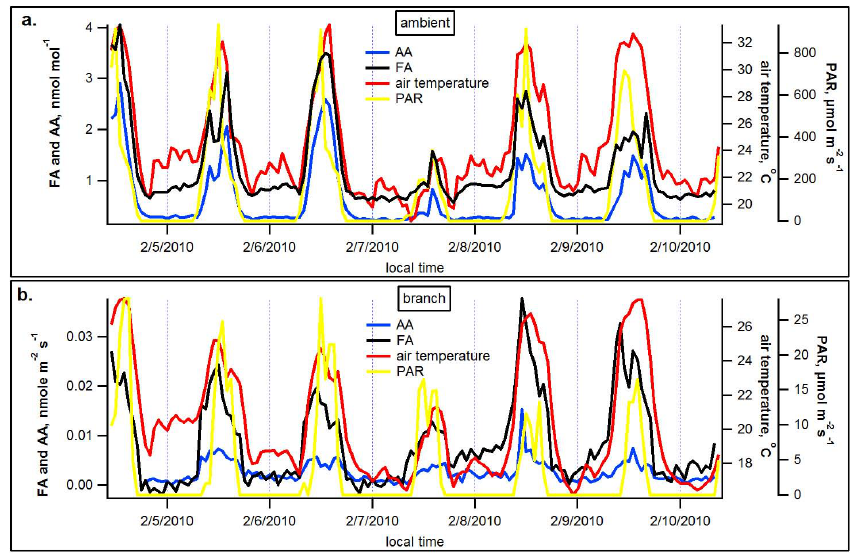
Fig. 1. Example of simultaneous FA and AA time series in the Biosphere 2 tropical rainforest mesocosm (a) ambient concentrations in the mesocosm (16m height) (b) branch emission rates from an isolated A. zerumbet branch. Temperature and PAR are also shown (ambient conditions at 20m height in mesocosm and in the branch enclosure).